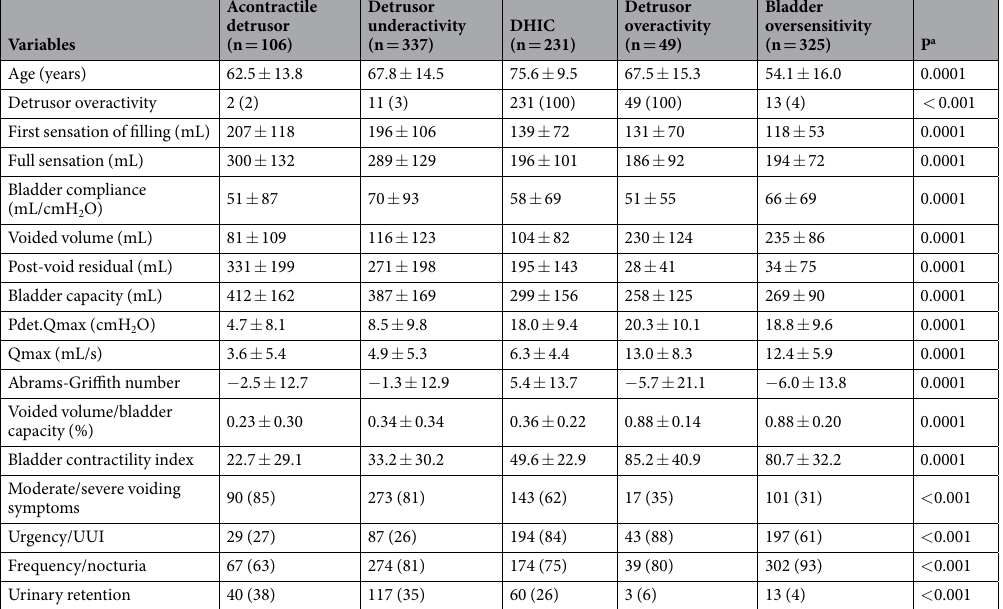
Table 3. Comparisons of videourodynamic diagnoses with bladder dysfunction (n = 1,048) DHIC = detrusor hyperactivity with impaired contractility. Data expression and other abbreviations are the same as in Table 1. a By Kruskal-Wallis test or chi-square